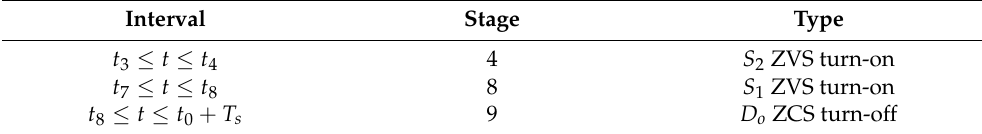
Table 1. Soft switching type. ZVS, zero voltage switching; ZCS, zero current